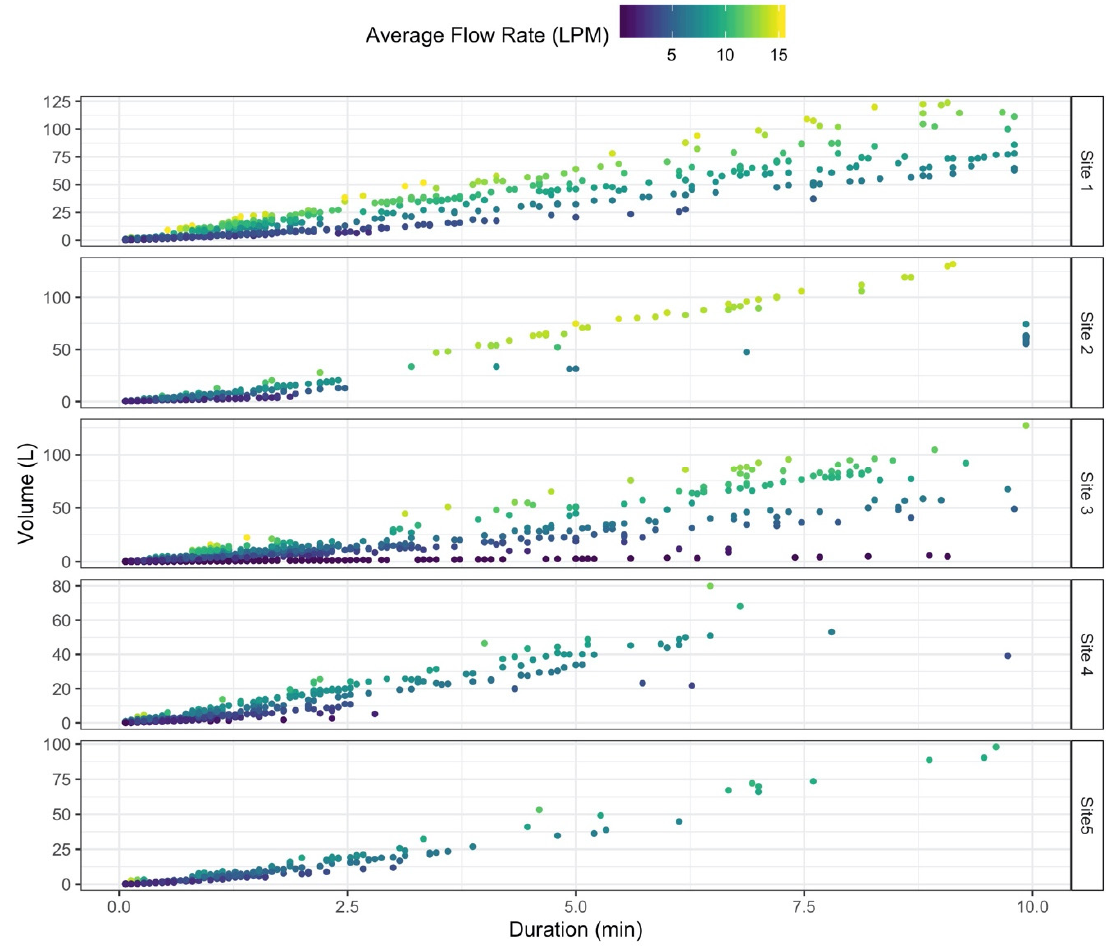
Figure 11. Duration (minutes) versus volume (liters) of 23,478 events logged at the 5 sites. Events presented are those with a duration of less than 10 min and average flow rate less than 15 LPM (96% of all the events that are not leaks). Color is assigned to each event based on its average flow rate (LPM). These three values have been used by other authors to identify and classify end uses events.